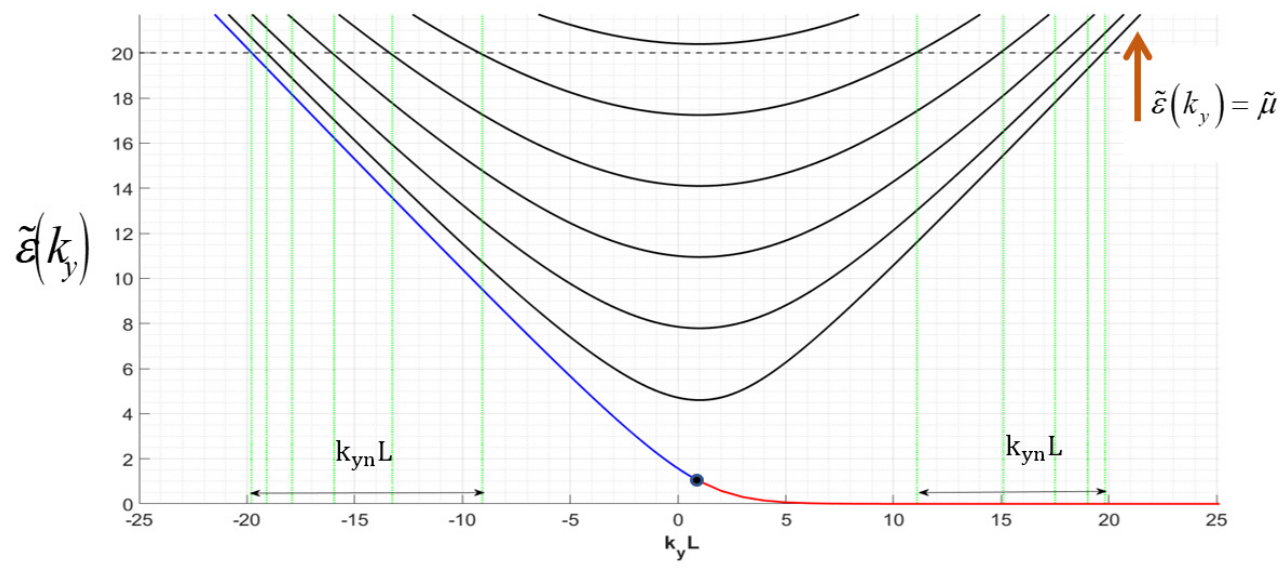
Figure 2. Illustration with respect to the zero-temperature approximation. Black lines correspond to confined modes, red line corresponds to the edge mode, and blue line corresponds to the first confined mode. The black point corresponds to the critical wavenumber in which the mutual transformation of the edge mode to the first confined mode takes place. The dotted horizontal line corresponds to the given electrochemical potential. The values 𝑘 (cid:3052)(cid:3041) denote the roots of Equation (17).